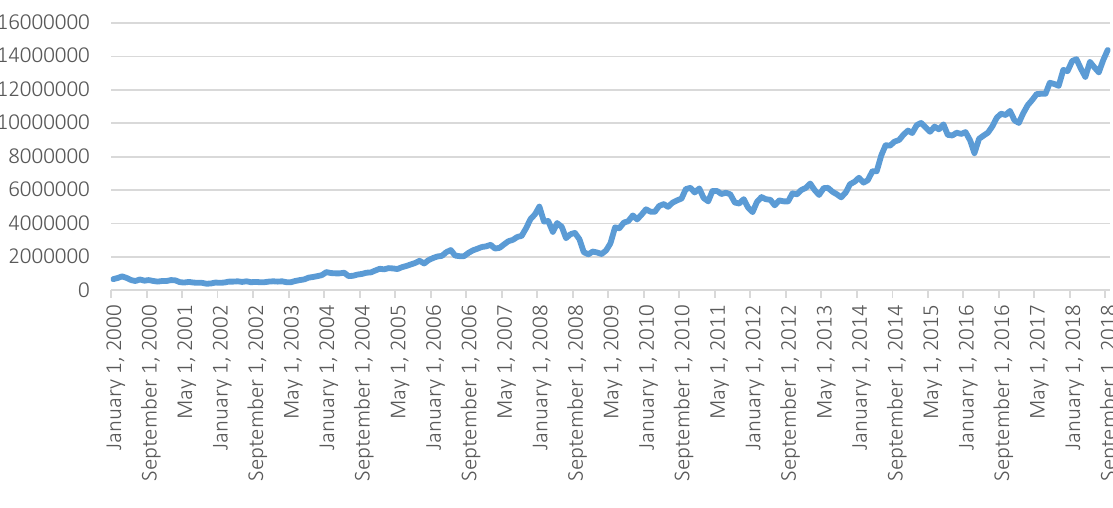
Figure 3B. Descriptive statistics – total market